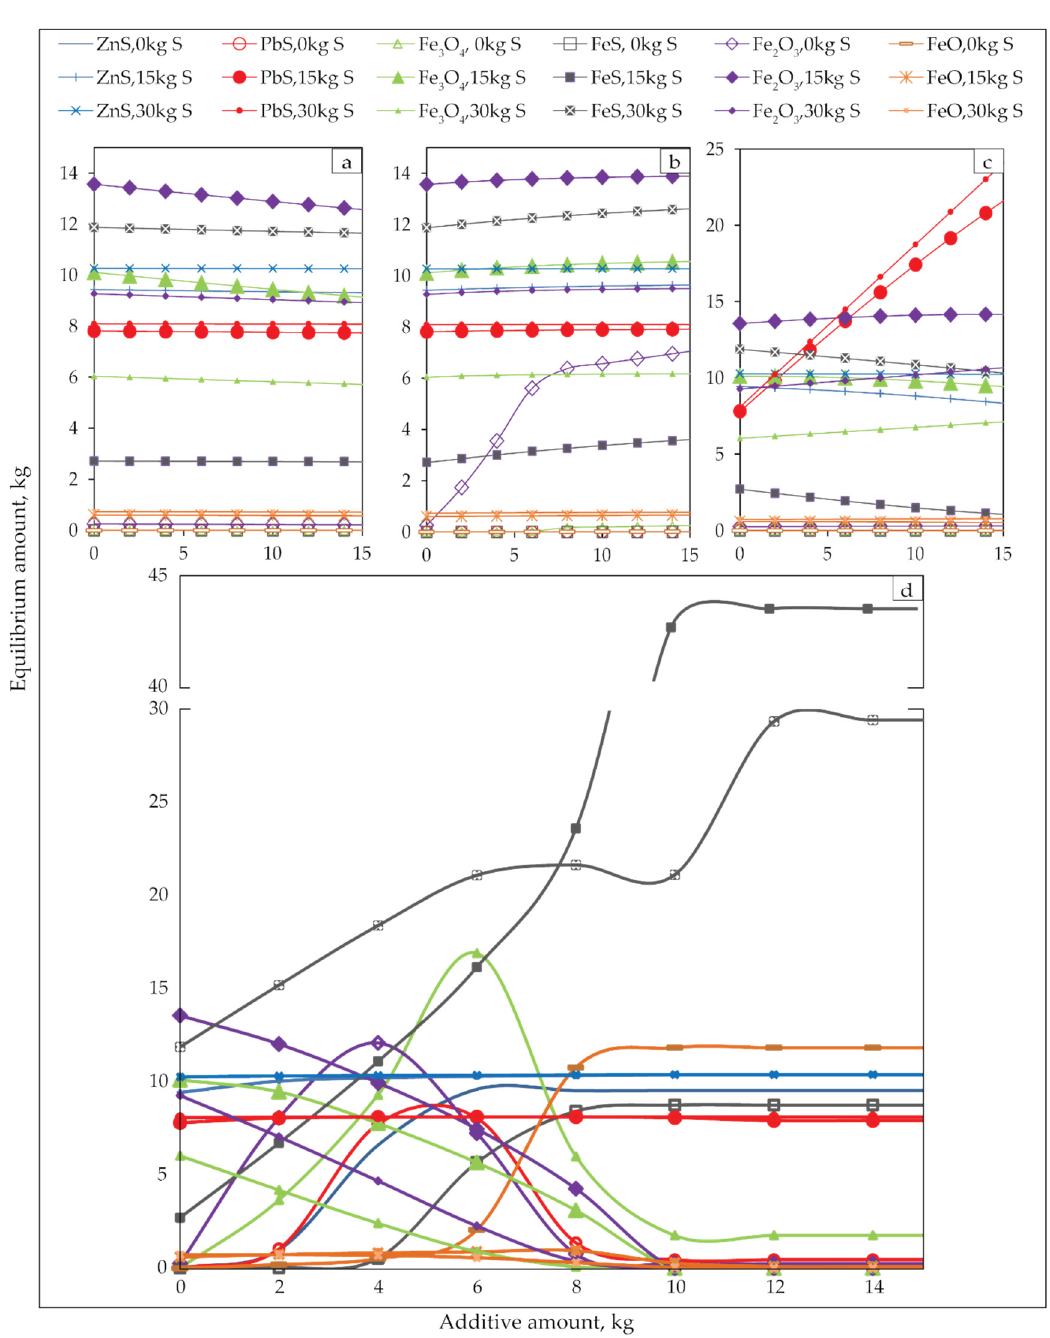
Figure 10. Equilibrium amounts of the products of sulfidization as functions of sulfidization agents and different additives ( a ) Na 2 CO 3 , ( b ) Cu 5 FeS 4 , ( c ) PbO, and ( d ) C at 550 °C.